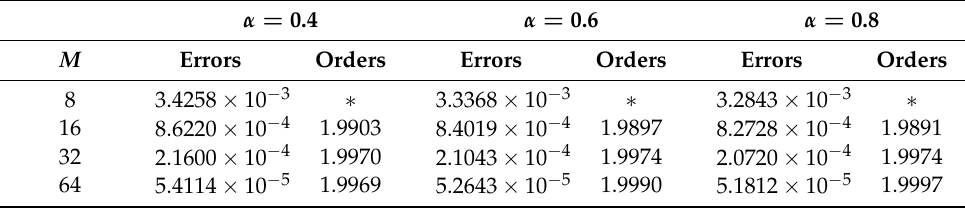
Table 8. Numerical spatial accuracy of Scheme III for different α (Example 2). α =